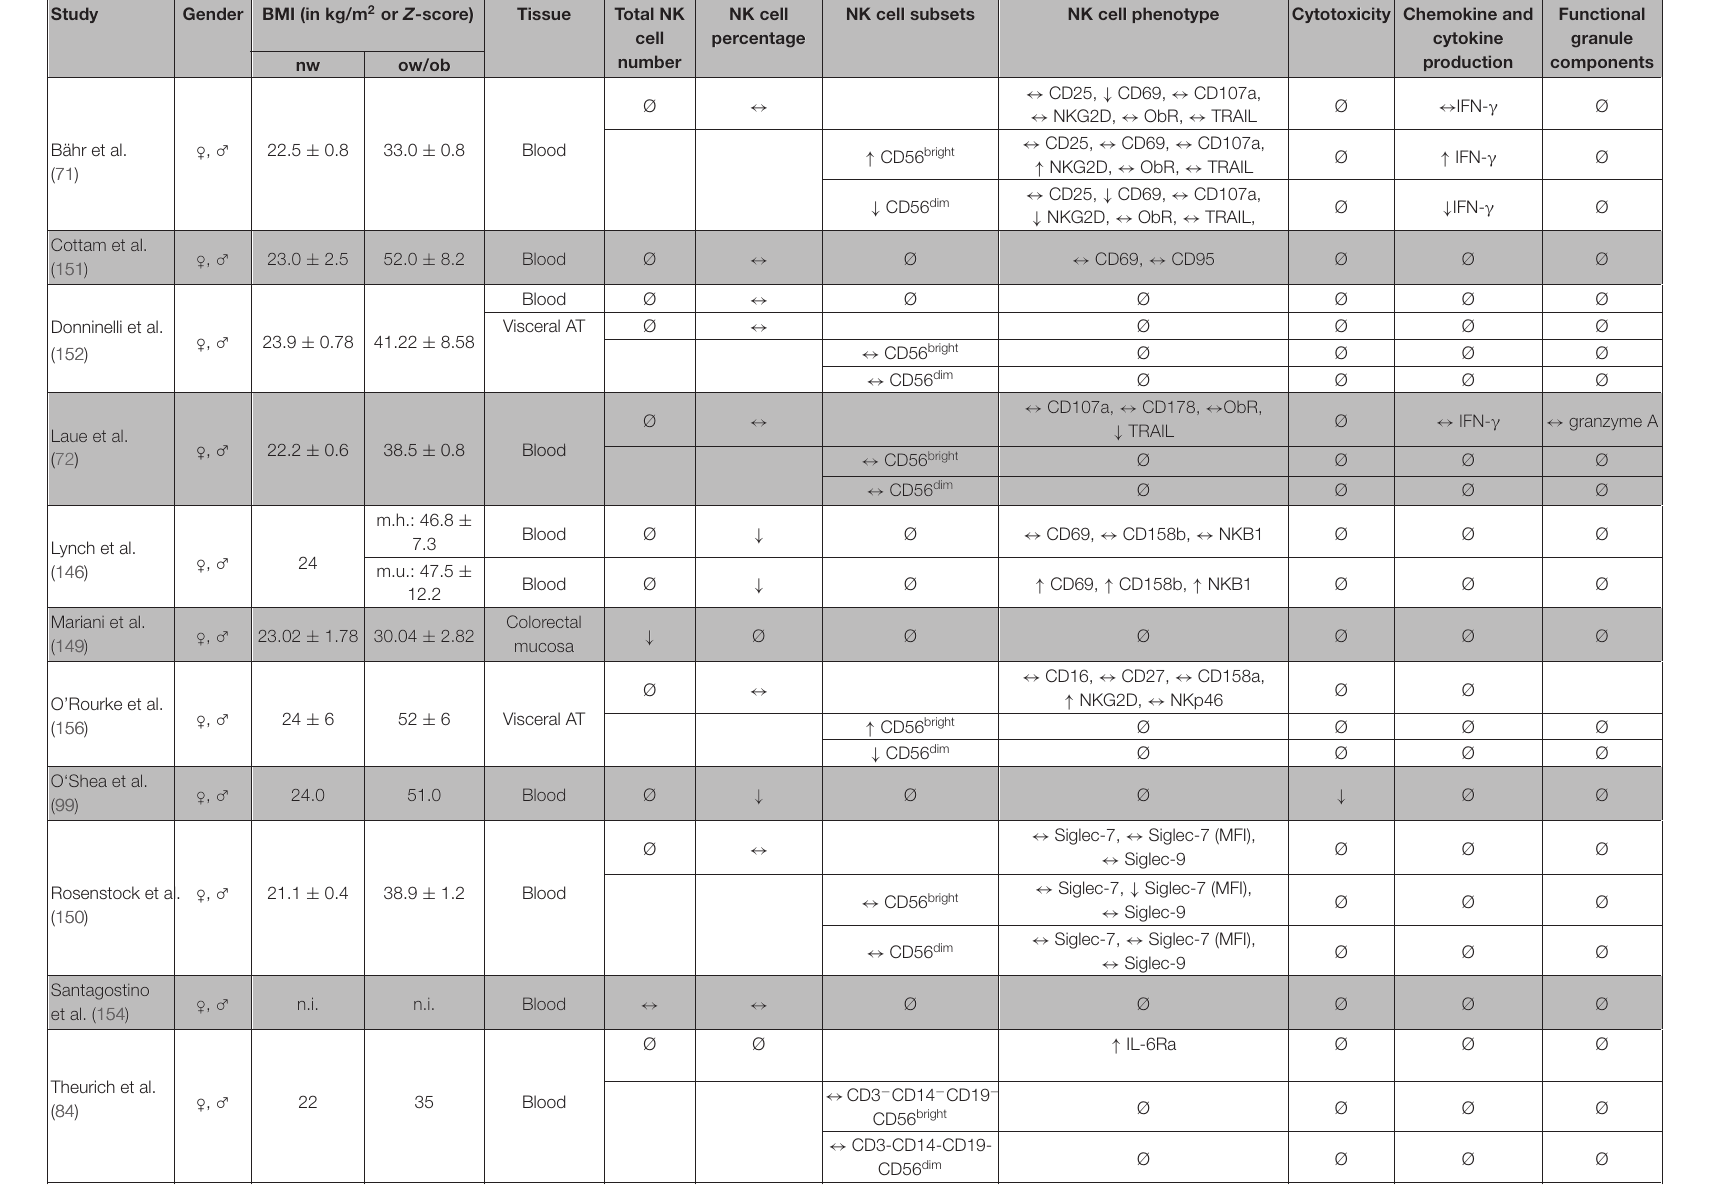
TABLE 4 | Overview of human studies investigating the effect of obesity on number, subsets, phenotype, and functional parameters of NK cells in different tissues.